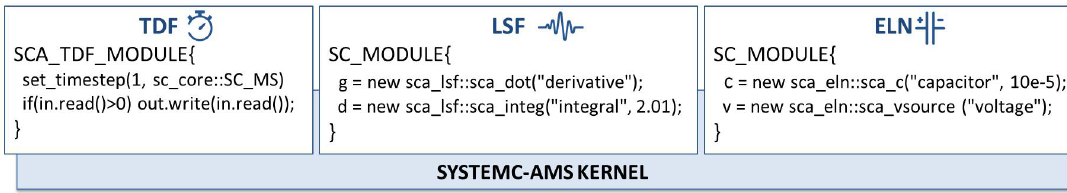
Figure 3. Abstraction levels supported by